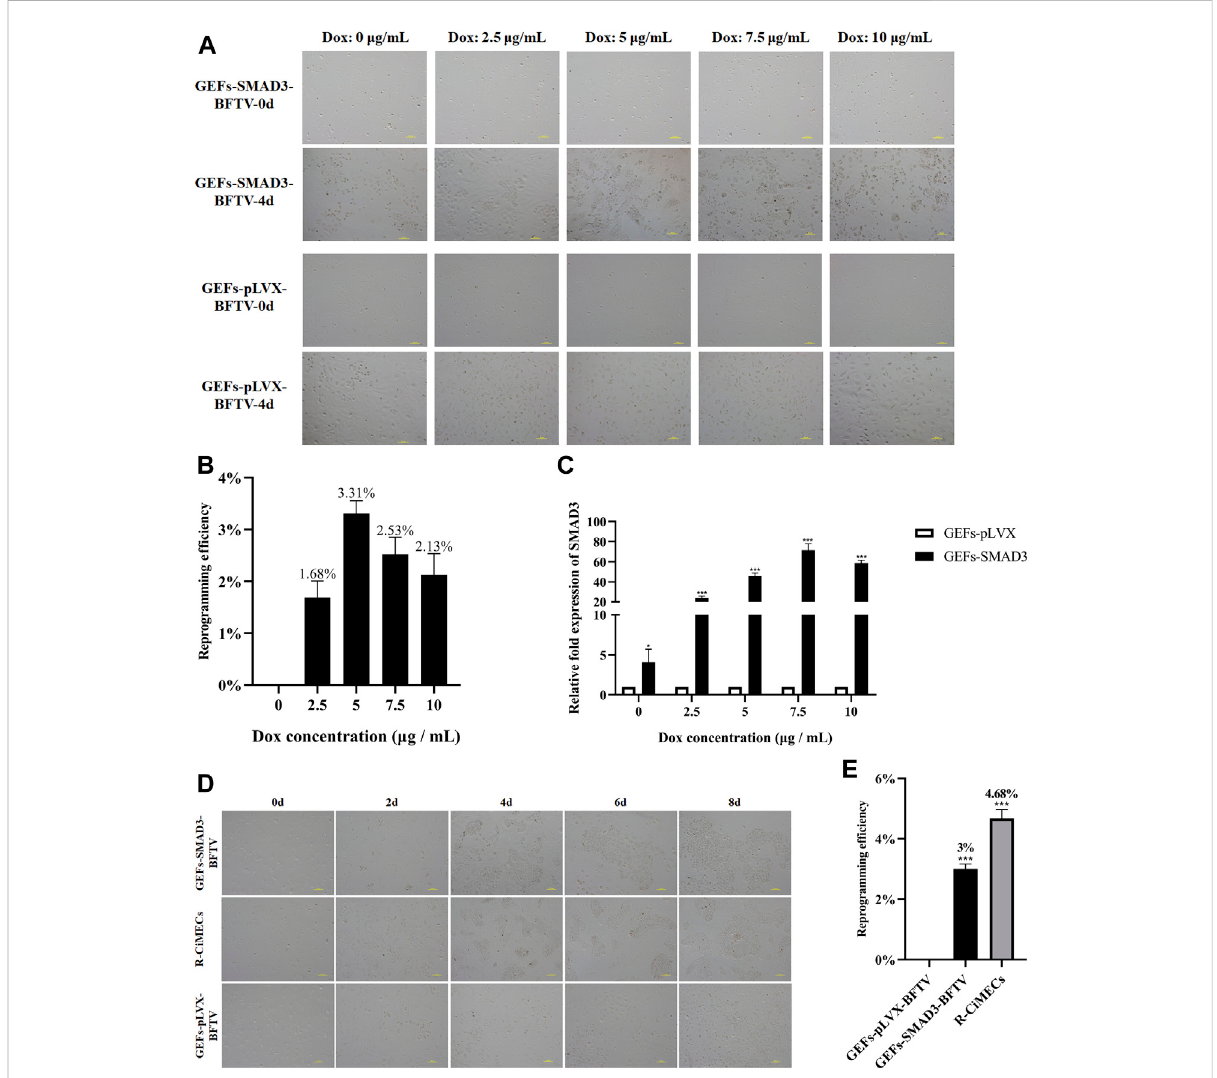
FIGURE 3 Effect of SMAD3 expression onreprogramming ef fi ciencyofgoatinducedmammaryepithelialcells. (A) The abilityofcellsto formindependent clones within 4 days under different concentrations of Dox induction. Scale bar, 100 μ m. (B) Reprogramming ef fi ciency of goat induced mammary epithelial cells under different concentrations of Dox treatment (Ef fi ciency (%) = No. of primary colonies/No. of seeded cells × 100%). (C) Changes in SMAD3 gene expression levels in goat fi broblasts induced by different concentrations of Dox. (Due to the speci fi city of the vector, there was a smallleakageofexpressionatDox=0 μ g/ml) n =3biologicalreplicates.Dataarerepresentedasthemean±SEM.* p < 0.05,*** p < 0.001(Student ’ st test). (D) Morphological changes during overexpression of SMAD3-induced reprogramming of goat fi broblasts into mammary epithelial cells (Dox = 5 μ g/ml). Scale bar, 100 μ m. (E) Overexpression of SMAD3 signi fi cantly improves thereprogramming ef fi ciency of goat induced mammary